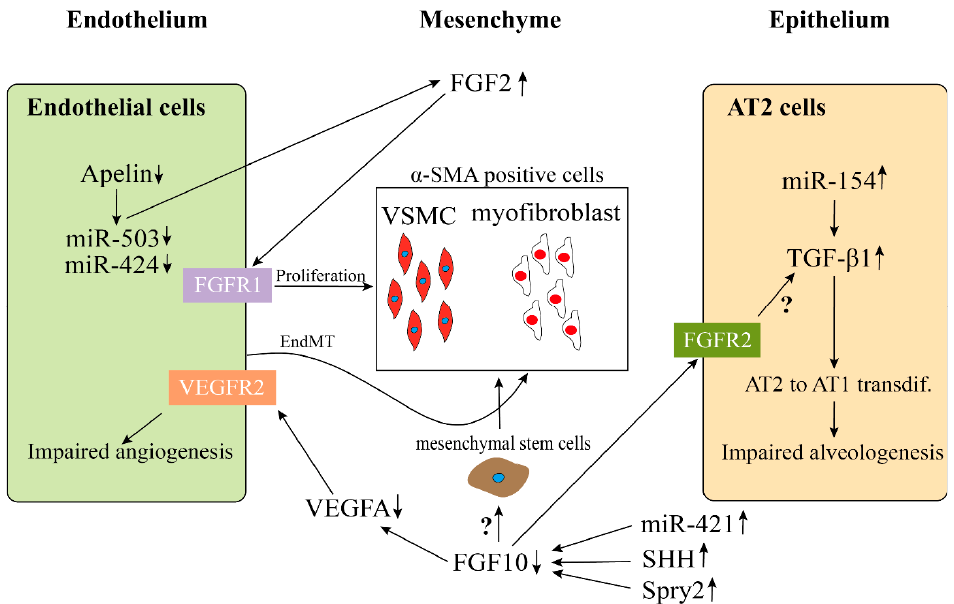
Figure 2. Possible endothelial–mesenchymal and epithelial–mesenchymal interactions in BPD-PH. Disrupted endothelial Apelin, miR-503 , and miR-424 results in an increased expression of FGF2 and induces the hyperproliferation of vessel smooth muscle cells (VSMC). An increase of α -SMA-positive myofibroblasts could be due to endothelial-mesenchymal transition (EndMT). The continuous high expression of miR-154 in AT2 cells stimulate the activation of TGF β 1 signaling pathway, which results in an impaired alveologenesis. Decreased FGF10 expression in BPD, which is caused by the upregulation of miR-421 , SHH, and Spry2, leads to the downregulation of VEGFA and upregulation of α -SMA, ultimately resulting in an impaired angiogenesis and an increase of α -SMA positive cells. However, whether FGF10 acts directly on the mesenchymal stem cells (MSC) to induce them to differentiate into α -SMA positive cells or through activating TGF β 1 signaling pathway needs to be further investigated.